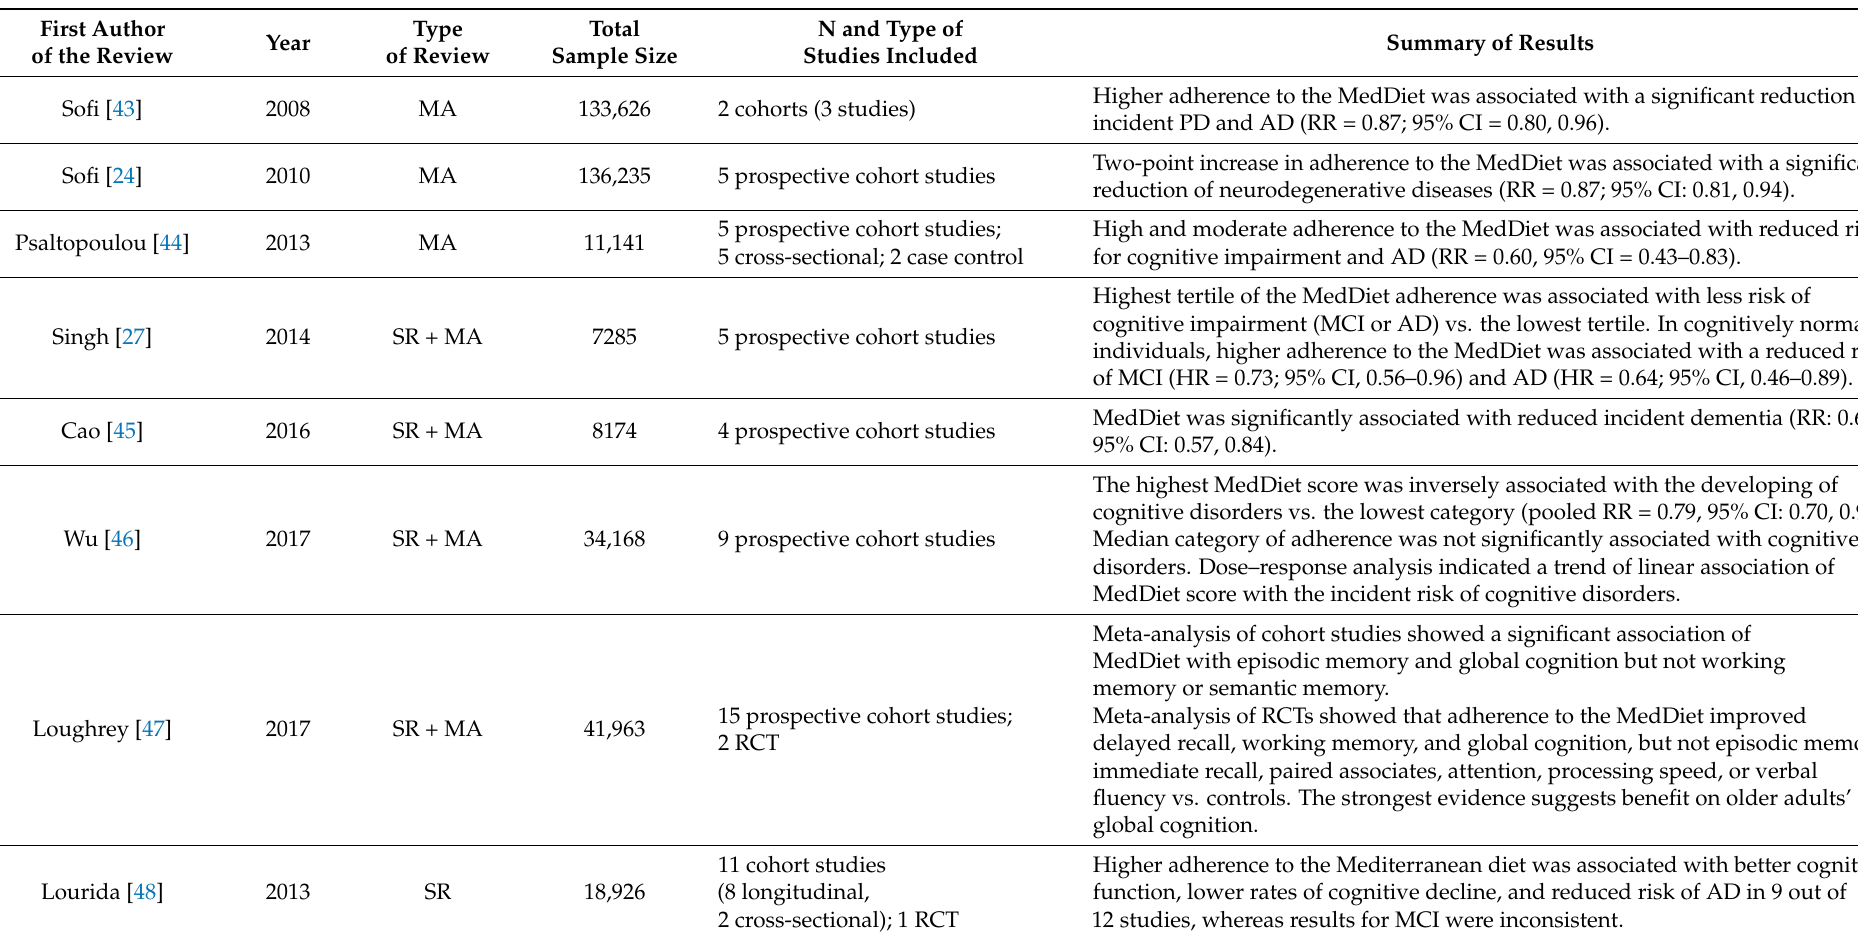
Table 1. Summary of systematic reviews and meta-analyses exploring the association of adherence to the MedDiet, which is the most studied dietary pattern in the medical literature, with cognitive decline and/or incident